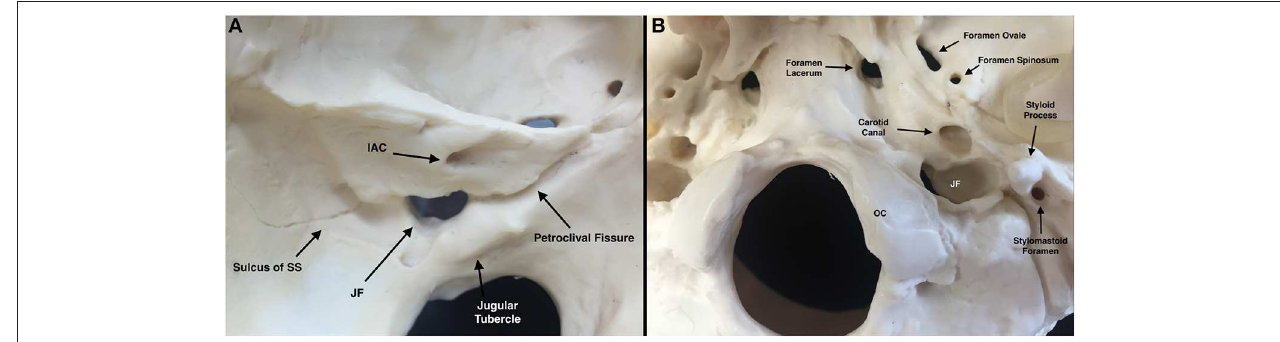
FIGURE 1 | Osseous jugular foramen (JF) and related structures [Modified from Ramina and Tatagiba (3)]. (A) Left intracranial view of JF. (B) Left extracranial view of JF. IAC, internal auditory canal; JF, jugular foramen; OC, occipital condyle; SS, sigmoid sinus.